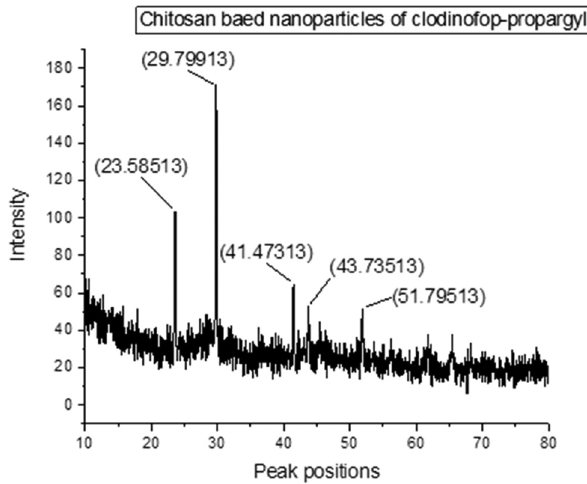
Figure 7: XRD analyses of chitosan - based NPs of clodinofop propargyl.